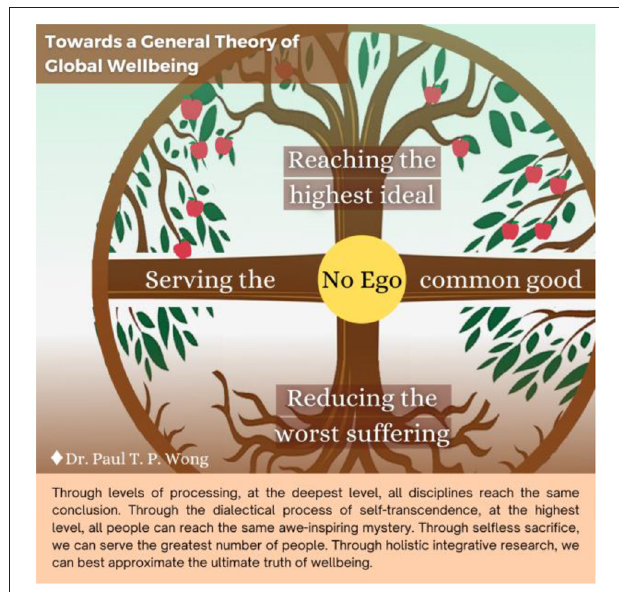
FIGURE 3 | Toward a general theory of global well-being.